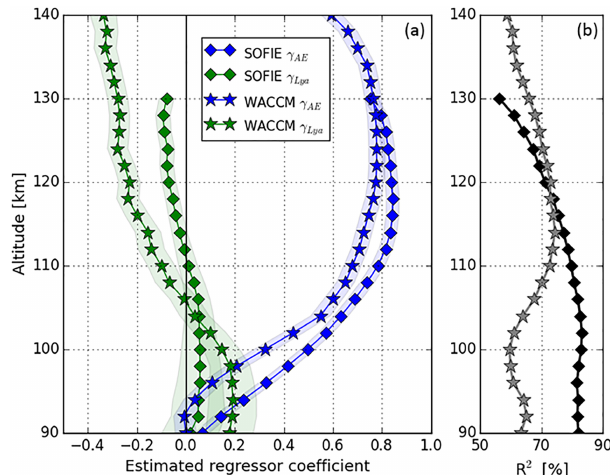
Figure 8. Results of the MLR performed on SOFIE (diamonds) and WACCM (stars) data throughout the lower thermosphere. (a) Esti- mates for the coefficients of geomagnetic activity (blue) and solar radiation (green), which can directly be compared to each other in terms of magnitude. (b) Total variation explained by the model for SOFIE (black) and WACCM